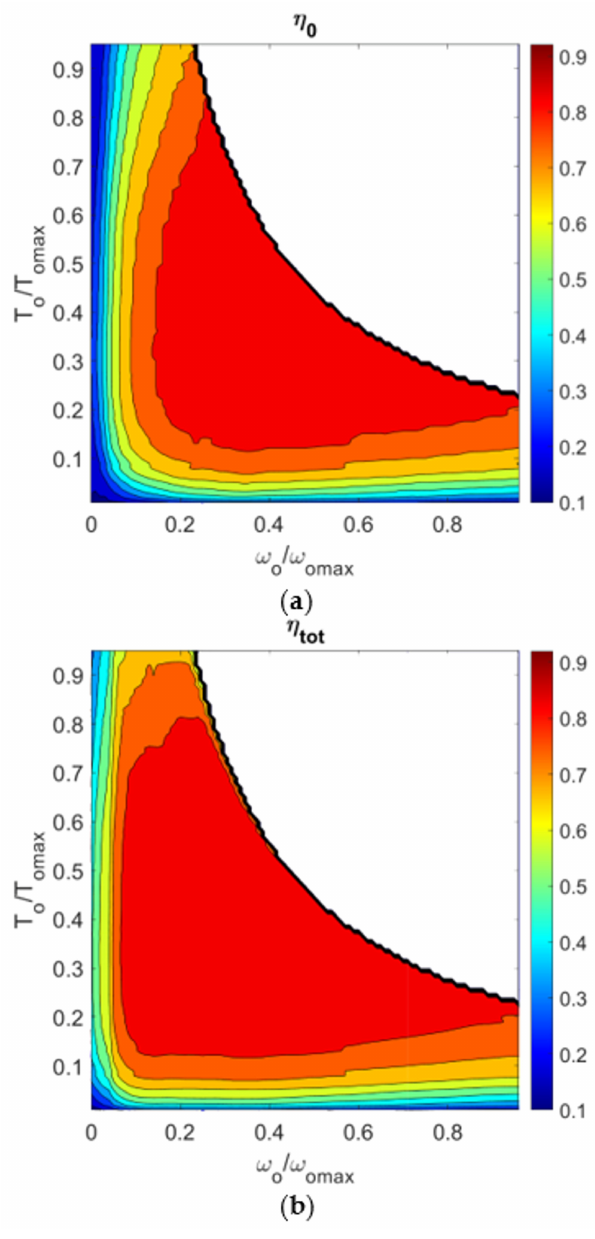
Figure 7. Comparison of the efficiency map provided by the single-motor ( a ) and dual-motor ( b ) powertrains ( ρ = 3.5, ω R,max = 0.8 ω omax and ω S,max = 1.7 ω omax